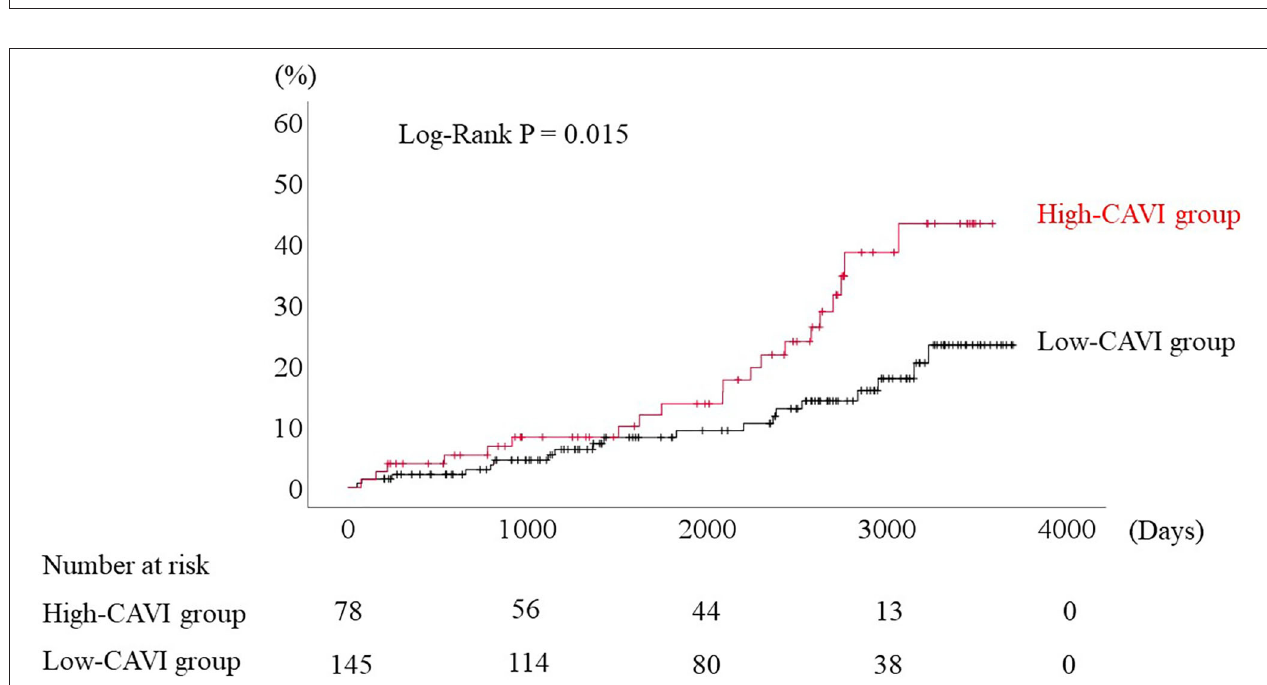
FIGURE 5 | Accumulated ischemic coronary event rates stratified by